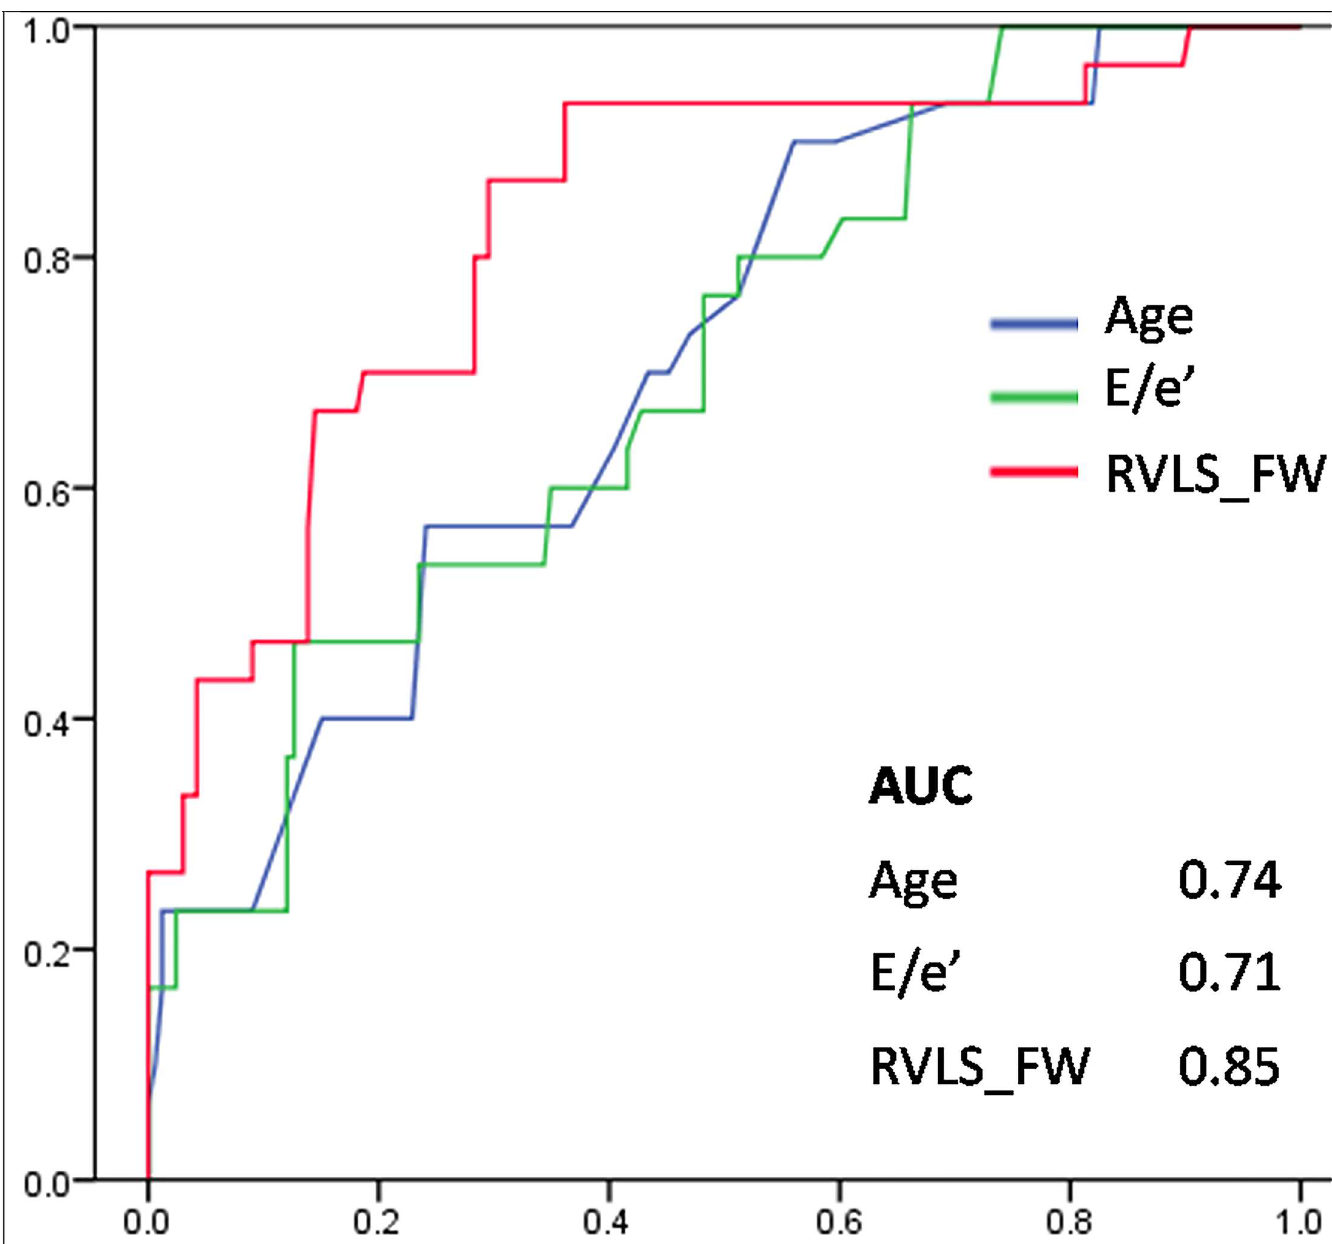
Fig 2. The areasunder the ROC curves for the predictor of impaired functional capacity were 0.74 for age, 0.71 for E/e’ and 0.85 for RVLS_FW. Abbreviations as describedin Tables 1 and